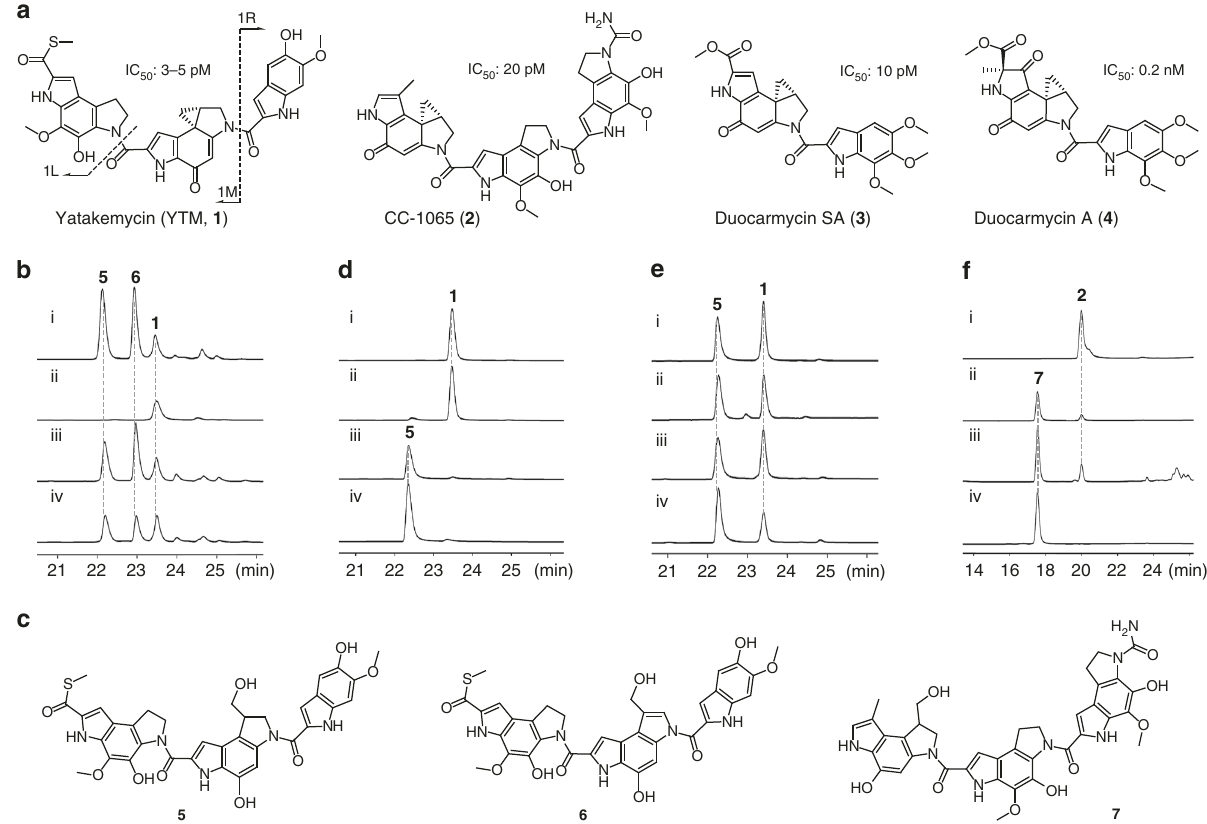
Fig. 1 Structures of cyclopropapyrroloindole compounds and characterization of cyclopropanoid cyclopropyl hydrolases (CCHs). a Structures of yatakemycin (YTM), CC-1065, and duocarmycins. 1 L, 1 M, and 1 R indicate the three subunits of YTM, respectively. The IC 50 reveals the cytotoxicity against L1210 cell line. b Genetic investigation of ytkR7 by HPLC analysis of the fermentation products (UV at 383 nm). (i) wild-type Streptomyces sp. TP- A0356; (ii) the Δ ytkR7 mutant Streptomyces sp. TG1310; (iii) the Δ ytkR7 mutant complemented with the ytkR7 gene in trans; and (iv) the Δ ytkR7 mutant complemented with the c10R6 gene from S . zelensis NRRL 11183. c Structures of compounds 5 , 6 , and 7 . d Biochemical characterization of YtkR7 with YTM as substrate. (i) YTM dissolved in the reaction buffer; (ii) boiled YtkR7; (iii) YtkR7; and (iv) standard of 5 . e Biochemical assays of the other selected CCHs using YTM as substrate. (i) C10R6; (ii) lin2189 from Listeria innocua Clip11262; (iii) ETI84332.1 from Streptococcus anginosus DORA_7 (from the human microbiota); and (iv) MA1133 from Methanosarcina acetivorans C2A. f Characterization of substrate speci fi city of the CCH protein C10R6 by HPLC analysis (UV at 374 nm). (i) CC-1065 dissolved in the reaction buffer; (ii) C10R6 with CC-1065 as substrate; (iii) the fermentation products of S . zelensis